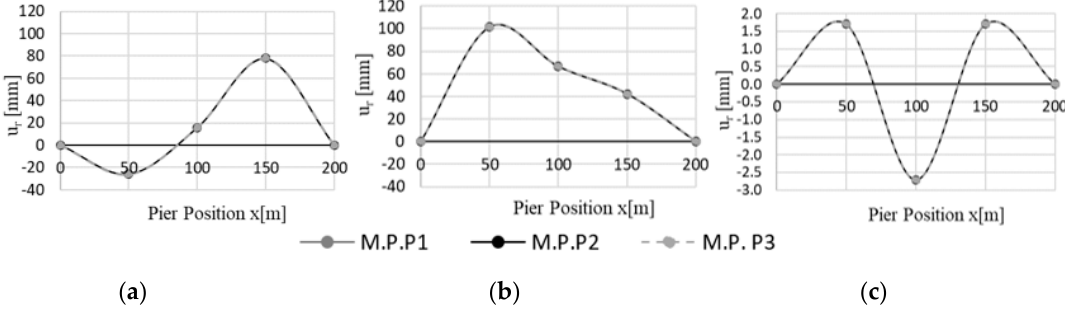
Figure 13. Irregular bridge—deck displacements derived by performing pushover analysis (ag = 0.7 g), with a load pattern proportional to the main mode shapes, with respect to different monitoring points (M.P.). Pushover with Mode 1 ( a ), Mode 3 ( b ) or Mode 4 ( c ).